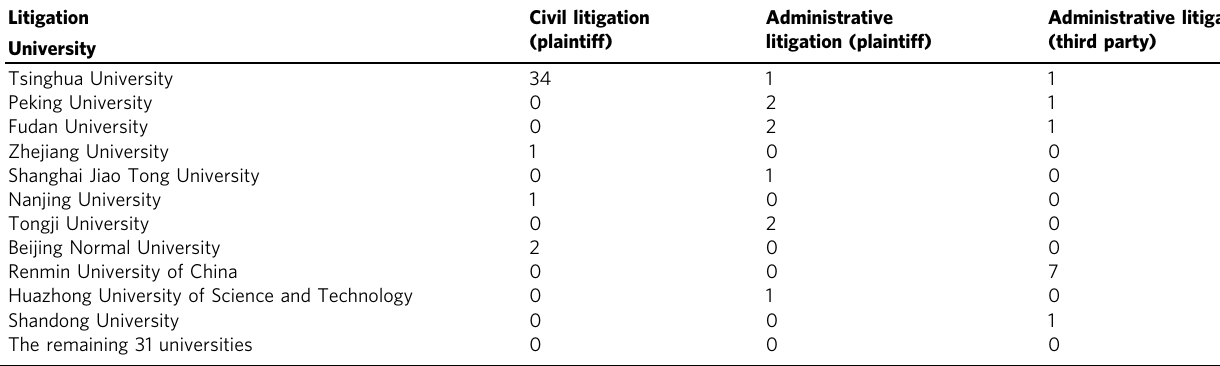
Table 5 Trademark litigation at the 42 fi rst-class universities.